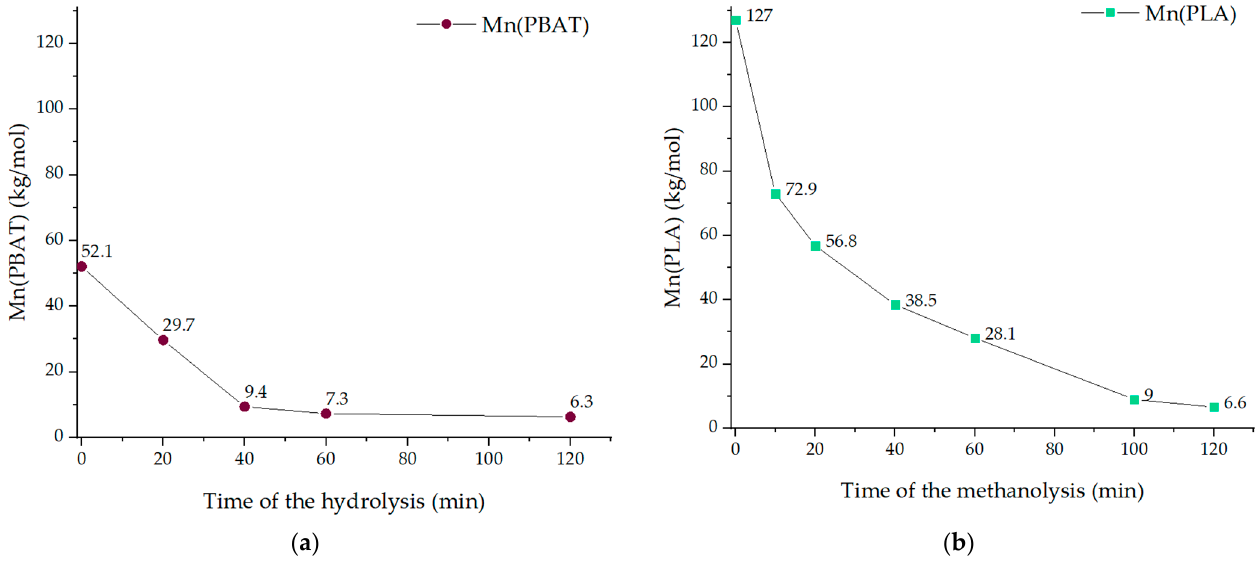
Figure 5. Number–average molecular weights ( M n ) of ( a ) PBATin dependence on the time of the hydrolysis and ( b ) PLA samples in dependence on the time of the methanolysis.